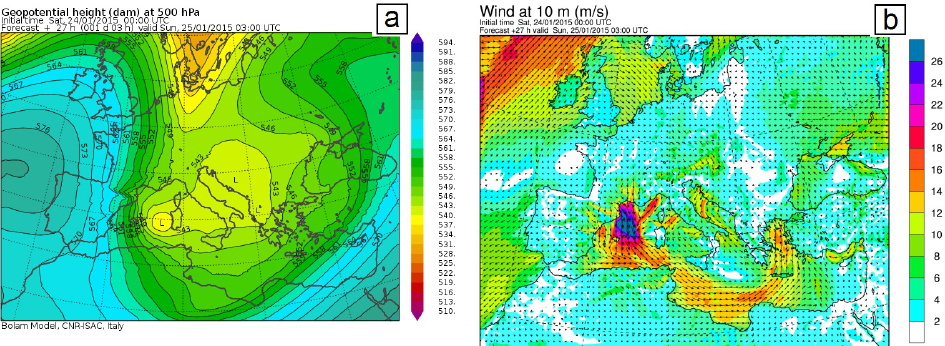
Figure 7. 25 January 2015 03:00 UTC: ( a ) Geopotential height (dam) at 500 hPa; ( b ) Wind (m/s) at 10 m (Bolam simulations).